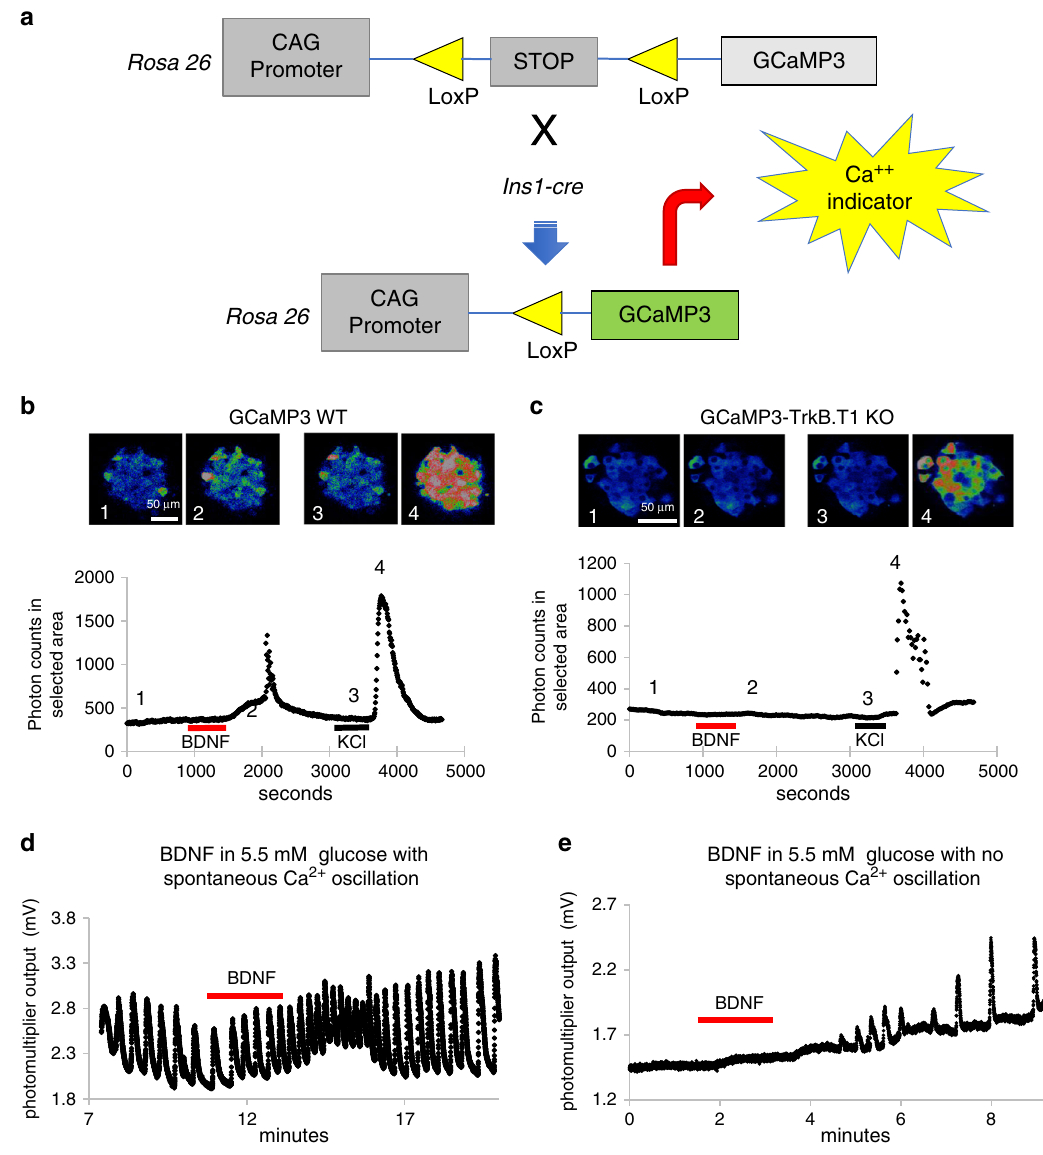
Fig. 4 TrkB.T1 mediates BDNF-induced Ca 2 + transients in mouse islets. a Schematic representation of the strategy used to measure Ca 2 + levels in β - cells. Intracellular calcium levels were visualized and quanti fi ed in islets expressing the genetically encoded calcium indicator GCaMP3 in β -cells using Cre under the insulin promoter (Ins1-cre). b , c Representative confocal images of WT ( b ) and TrkB.T1 KO ( c ) Ins1-cre-GCaMP3-expressing islets maintained in 3 mM glucose and treated sequentially with 10 ng/ml BDNF (red bar) and 20 mM KCl (black bar) as control. Images were acquired every 2 s, and intensity was plotted (bottom graph). Numbers (1 – 4) indicate the time at which the images were taken. Note the lack of response to BDNF in the TrkB.T1 KO islets. d , e Examples of changes in amplitude and frequency of Ca 2 + oscillation induced by BDNF (10 ng/ml) in 5.5 mM glucose-treated islets. When islets are oscillating, BDNF increases the amplitude and frequency of the oscillations ( d ), whereas BDNF initiates the oscillations when islets are not spontaneously oscillating ( e